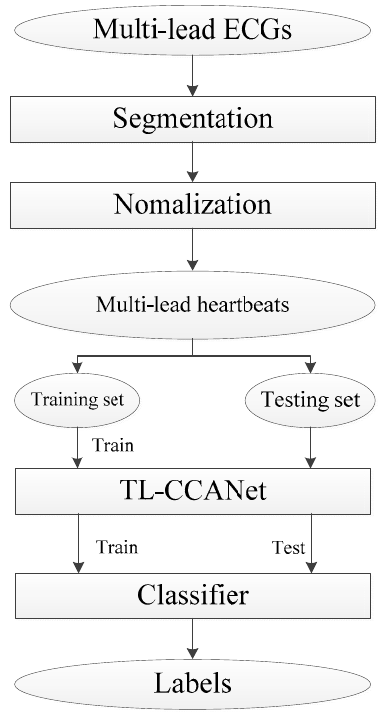
Figure 1. The specific process of the ECG classification based system.